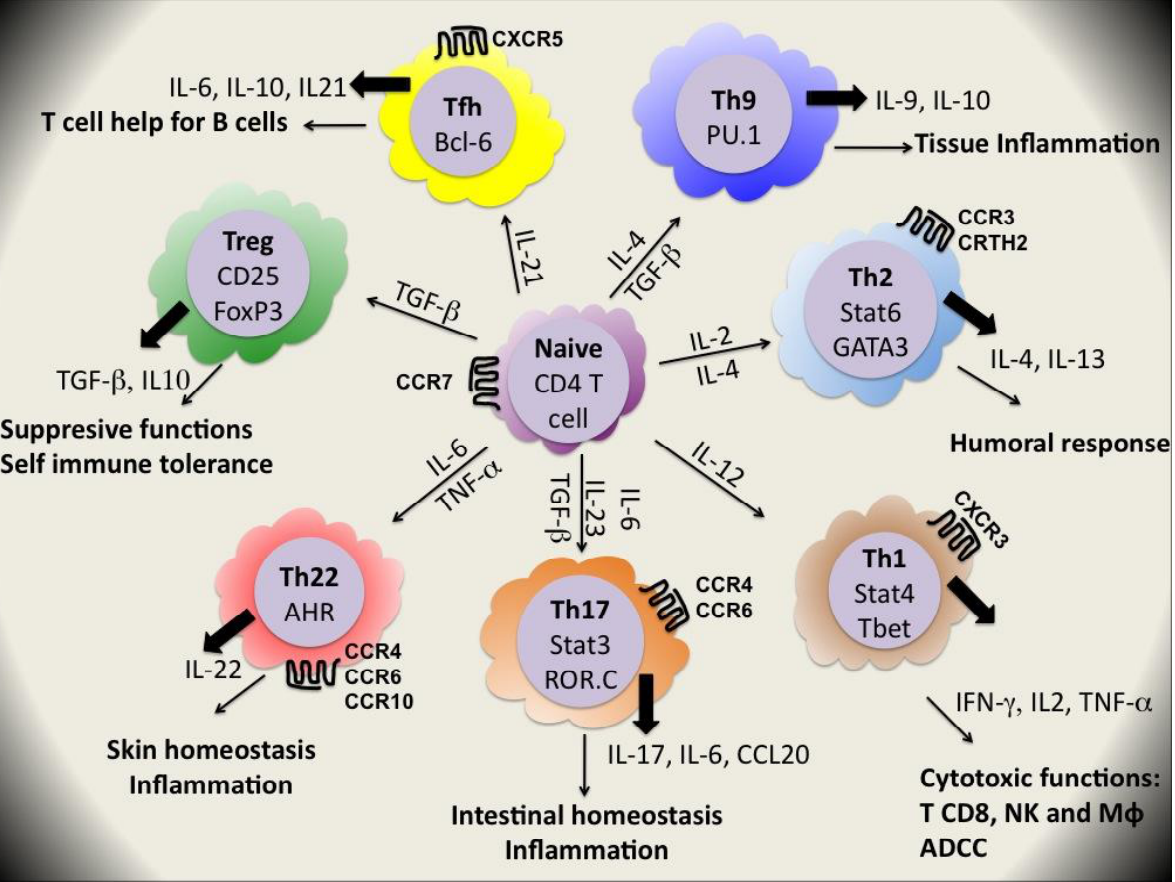
Th17 cells, a subset of helper T cells, are identified in situ as a population of CD4 + memory T Figure 2 Fevrier et al ., 2010